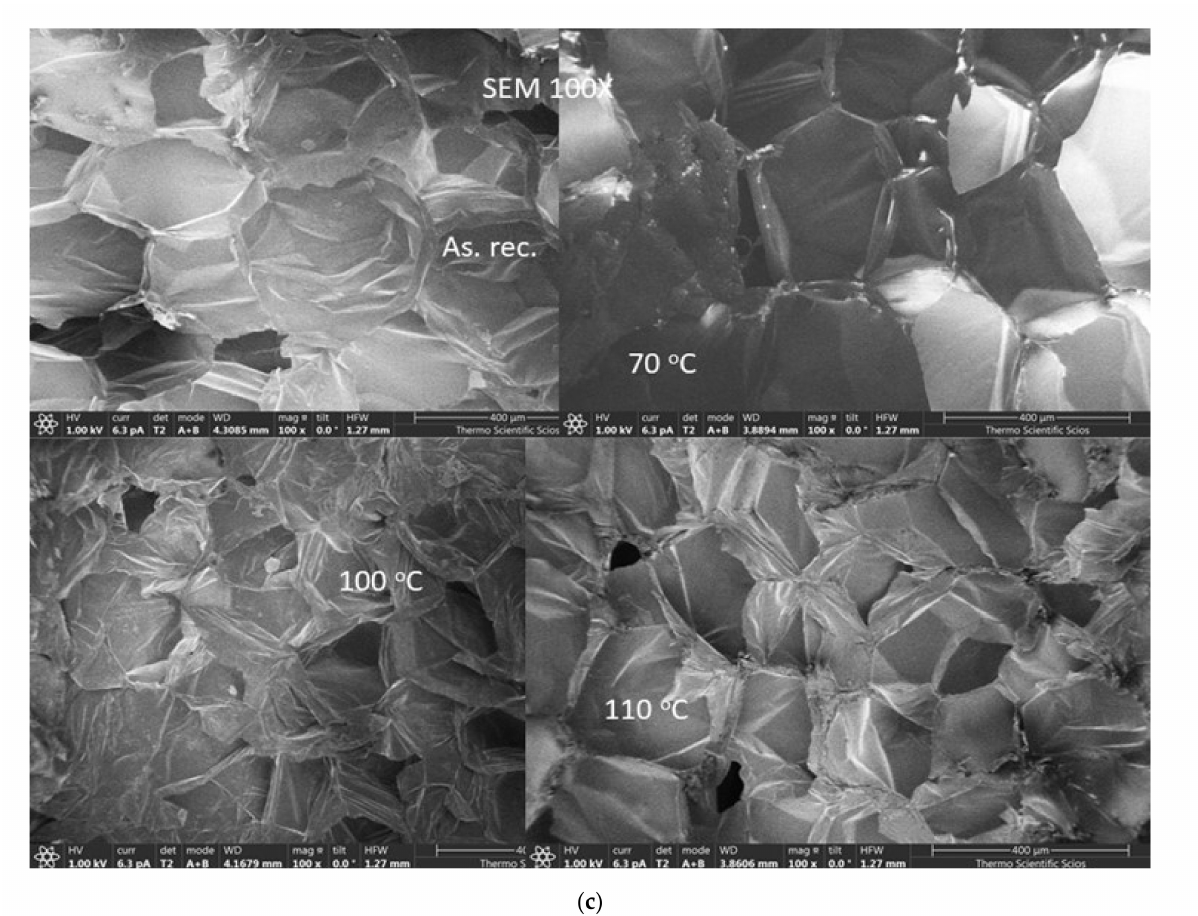
Figure 3. ( a ) Photo images from the samples (from left to right: As received, annealed at 70 ◦ C, annealed at 100 ◦ C and annealed at 110 ◦ C). ( b ) Optical microscope images from the samples. ( c ) Scanning Electron microscope images from the samples.